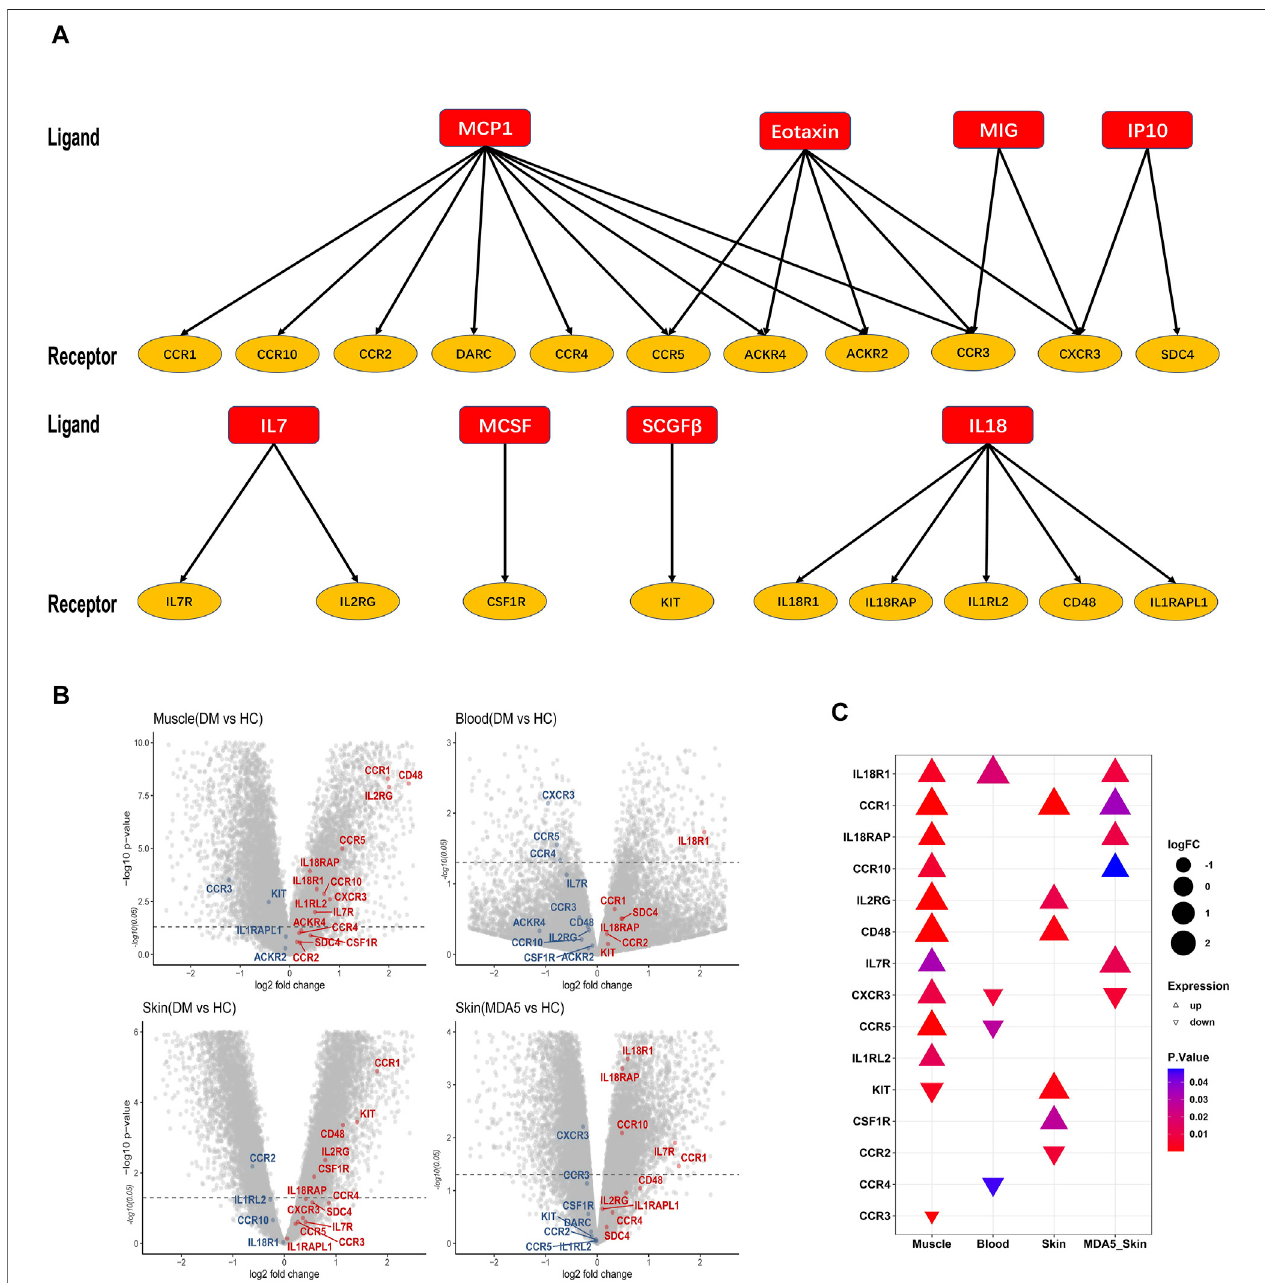
FIGURE 3 | The expression of receptors of the differentially expressed cytokines. (A) The ligand-receptor database (ramilowski_pairs) was analyzed with the R packagecelltalkertoidentifyatotalof20receptorscorrespondingtothe8differentiallyexpressedcytokines. (B) Thevolcanoplotsshowedtheexpressionof20selected receptors in four different databases (GSE143323, GSE125977, GSE142807, and GSE128314). Red color: up-regulated expression; Blue color: down-regulated expression. (C) Fifteen signi fi cant ( p < 0.05) receptors were identi fi ed from the four selected GEO databases.